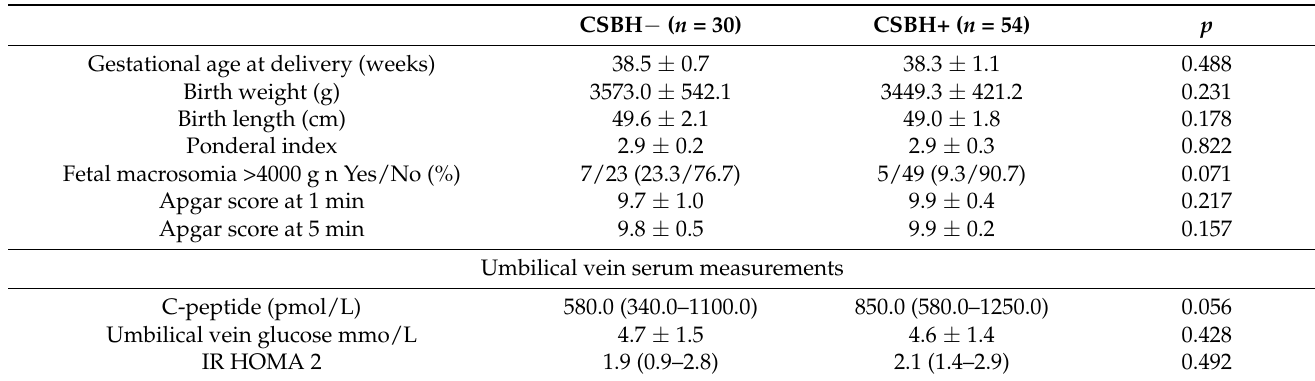
Table 2. Neonatal characteristics.